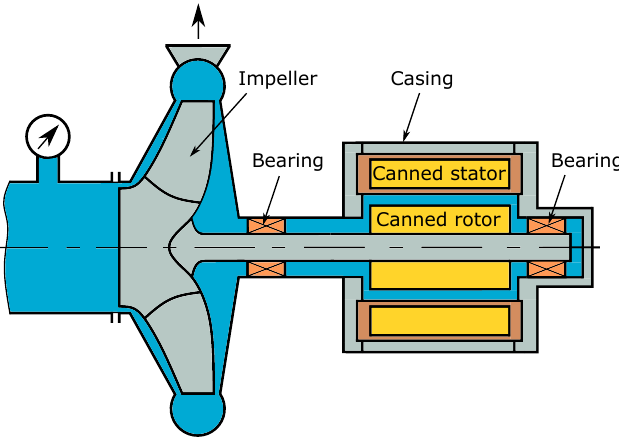
Figure 1. Canned motor